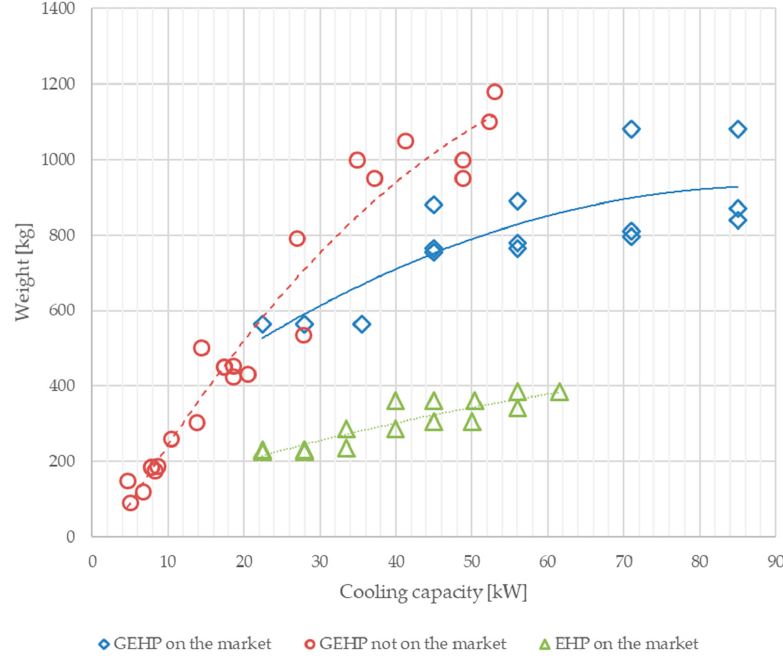
Figure 7. Weight of EHP, oldest and newest GEHPs as a function of cooling capacity.